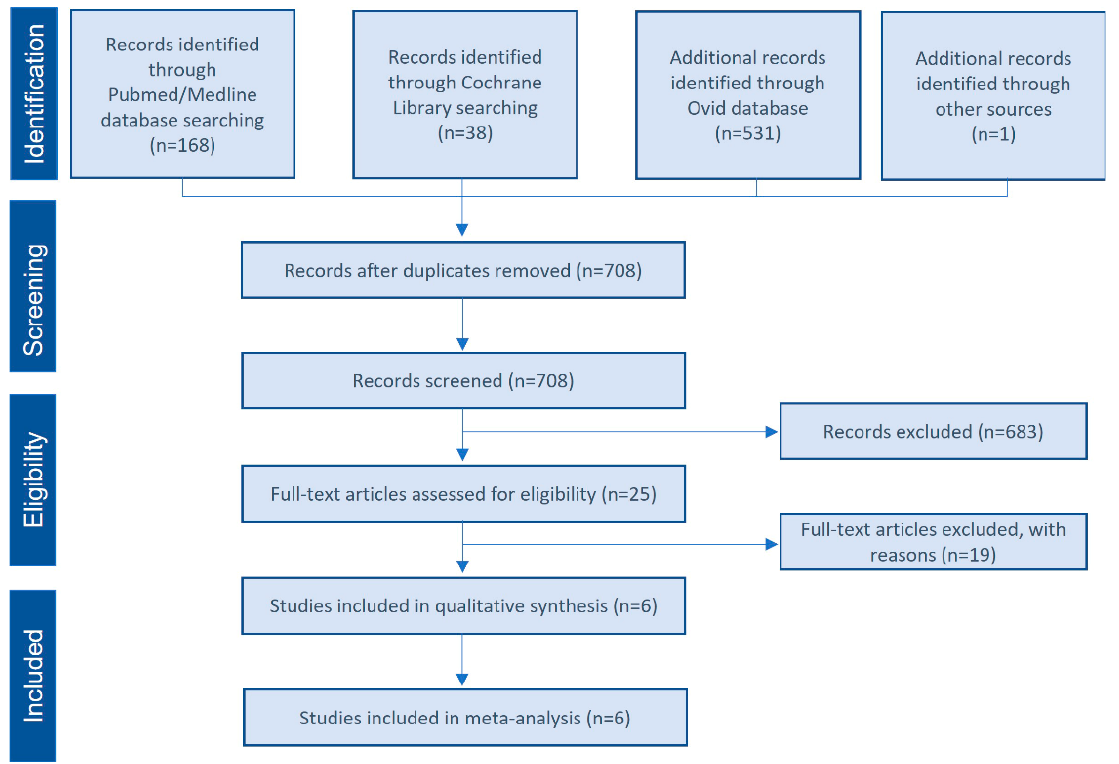
Figure 1. Selection flow diagram. PRISMA flow diagram of the screening and selection process.